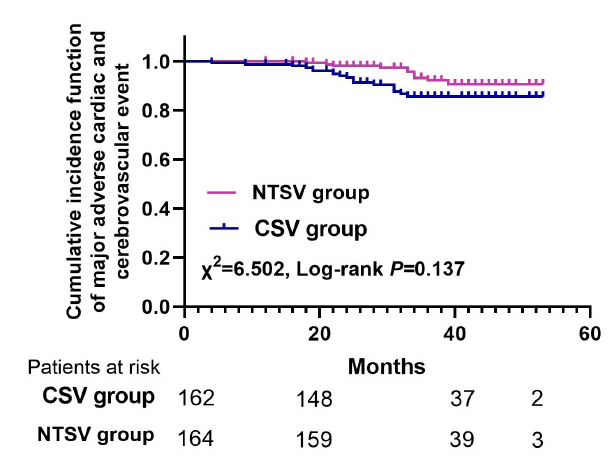
Fig. 3 - The cumulative incidence function of saphenous vein graft occlusion between the conventional saphenous vein (CSV) harvesting technique group and the no-touch saphenous vein (NTSV) harvesting technique group.